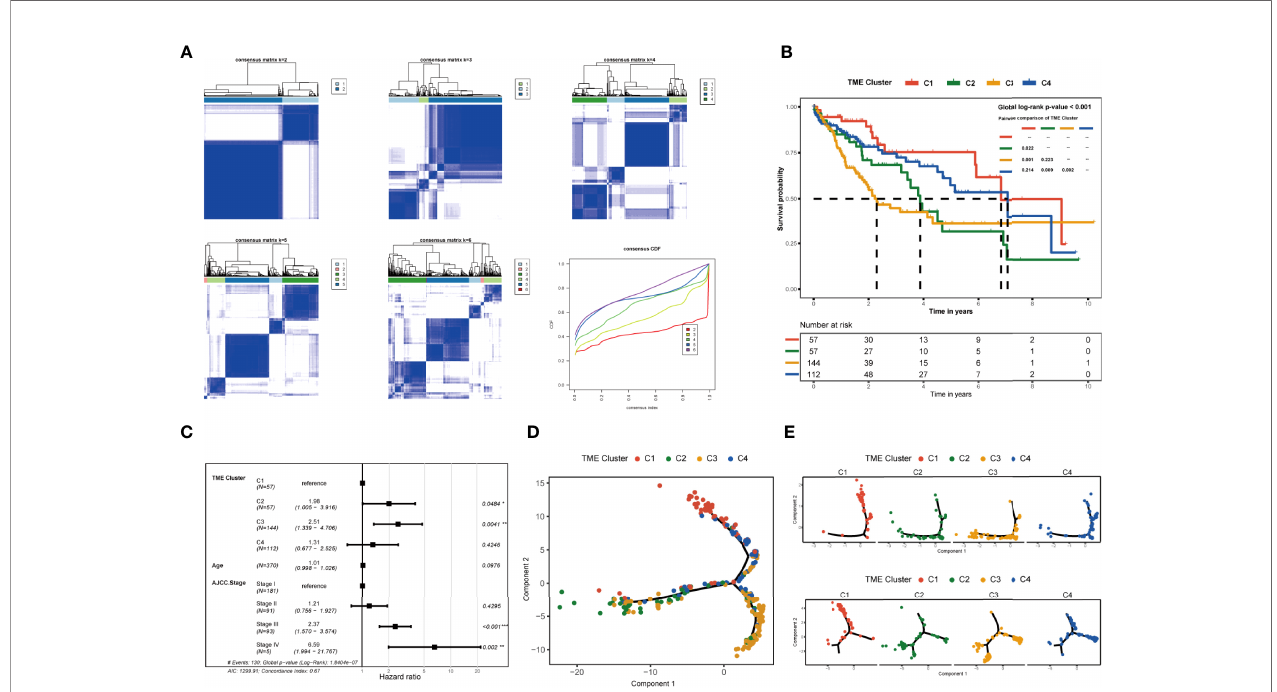
FIGURE 2 | Identi fi cation and clinical characteristics of TME subgroups. (A) Consensus clustering displaying the robustness of sample classi fi cation using multiple iterations (×1,000) of k-means clustering. The consensus distribution function (CDF) depicting the cumulative distribution from consensus matrices at a given cluster number (k). (B) Kaplan – Meier curves for overall survival of 370 patients in TCGA database showed the association between TME subtypes and overall survival (global log-rank test, p = 0.00033). (C) Forest plots showing multivariate Cox regression analyses of the TME class, age, and TNM stage on the overall survival of LIHC patients. (D) Pseudotime trajectory analysis speculated the developmental relationship of the clusters based on the differential genes. (E) Pseudotime trajectory analysis of 370 patients in TCGA based on the glycan biosynthesis and metabolism pathway-related genes and cellular processes (including transport and catabolism, cell growth and death, cellular community, and cell motility) pathway-related genes. *p ≤ 0.05, **p ≤ 0.01, ***p ≤